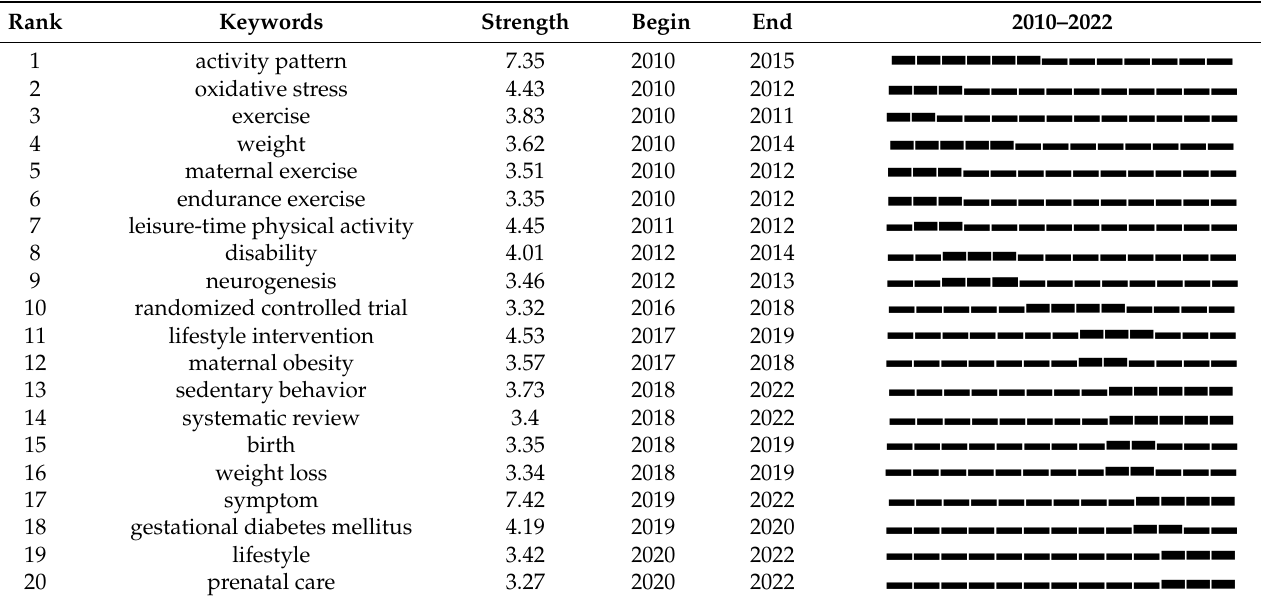
Table 3. Top 20 keywords with the strongest citation bursts.